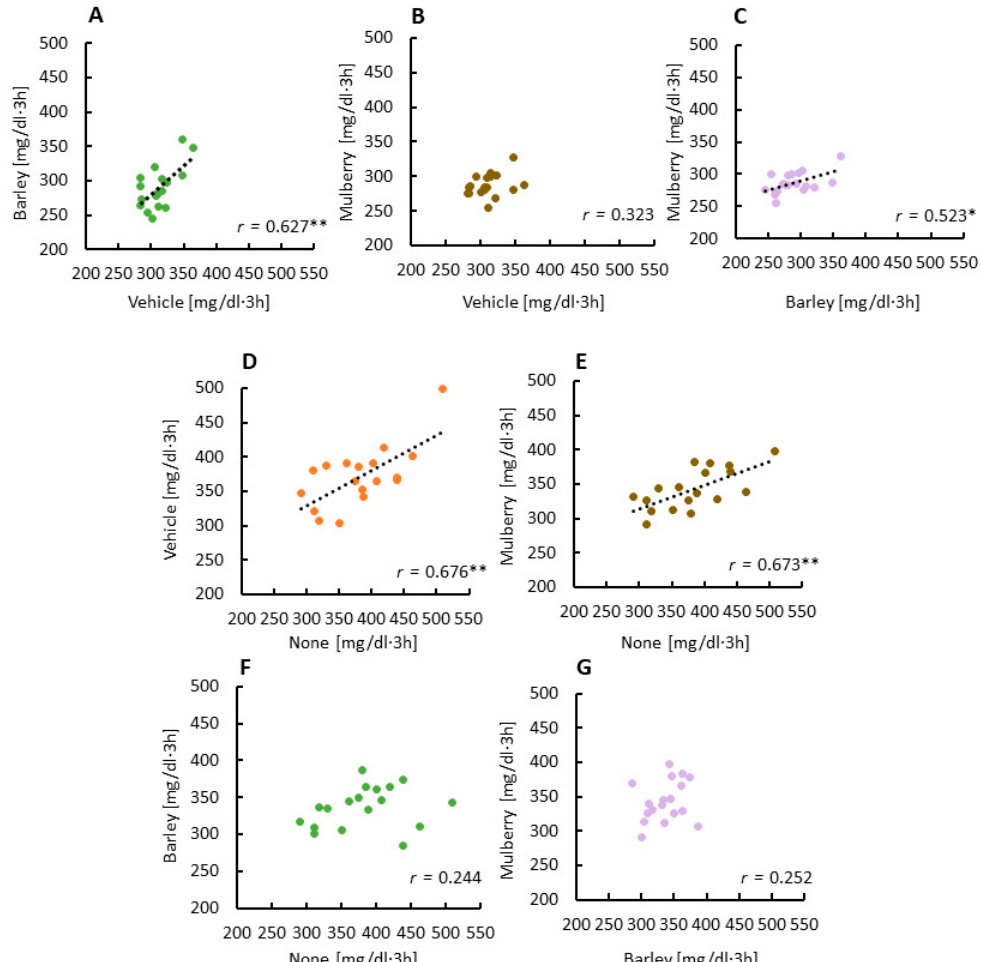
Figure 2. The relationship between area under the curve (AUC) glucose levels between each session. Correlations of glucose AUC between the vehicle and barley groups at snack time ( A ), correlations of glucose AUCs between the vehicle and mulberry groups at snack time ( B ), correlations of glucose AUC between the barley and mulberry groups at snack time ( C ), correlations of glucose AUC between the none and vehicle groups at dinner time ( D ), correlations of glucose AUC between none and mulberry groups at dinner time ( E ), correlations of glucose AUC between the none and barley groups at dinner time ( F ), correlations of glucose AUC between the barley and mulberry groups at dinner time ( G ). * p < 0.05, ** p = 0.01 ( A , D , E